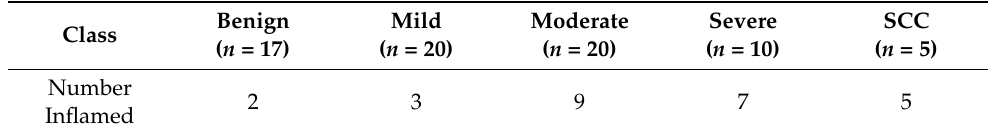
Table 4. Number of inflamed samples per class.